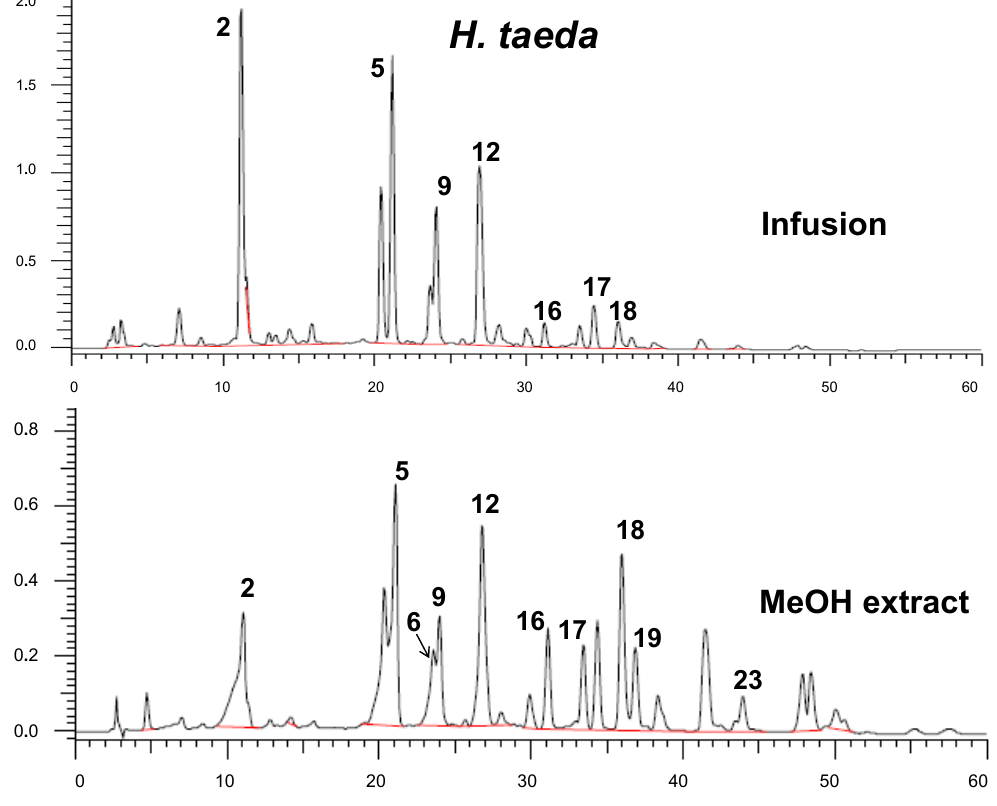
Figure 3. Comparative HPLC-DAD chromatograms at 250 nm of “baylahuen” ( Haplopappus spp.) infusions (tea) and methanol extracts. For the tentative identification of the constituents, please see Tables 1 and 2. Table 1. Identification of phenolic compounds in Haplopappus spp. tea and methanol extract by HPLC-DAD-ESI-MS